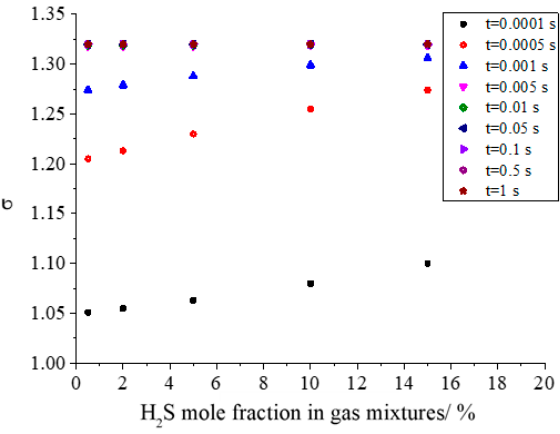
Figure 17. Effect of H 2 S concentration on geometric standard deviation.